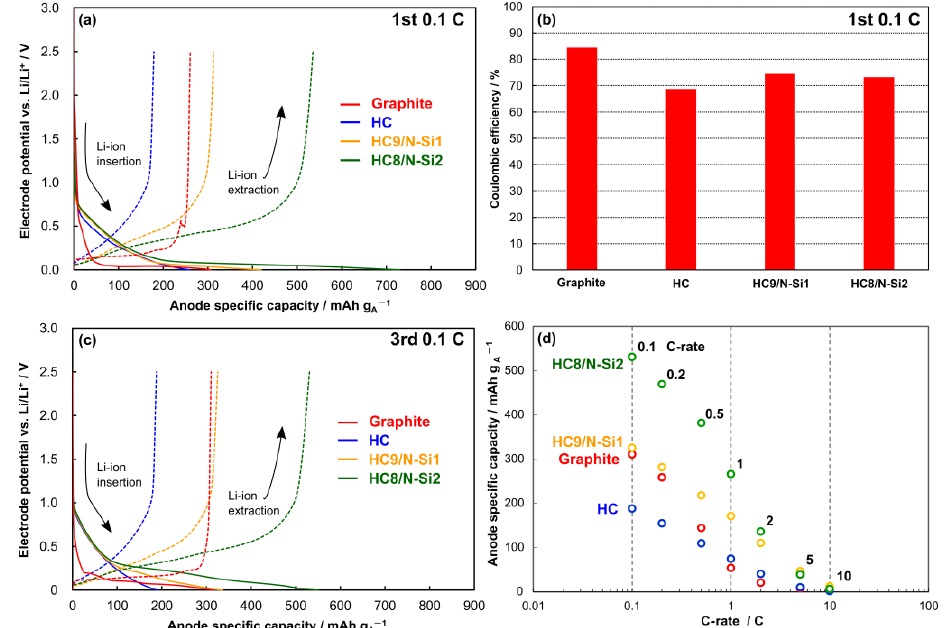
Figure 1. Performance of anode-active materials in the half-cell configuration: ( a , c ) electrode potential as a function of anodic specific capacity at 0.1 C in the ( a ) first and ( c ) third cycles; ( b ) Coulombic efficiencies (CEs) in the first cycle; ( d ) rate performance at 0.1 – 10 C. The data of the third cycle for each C-rate are shown.